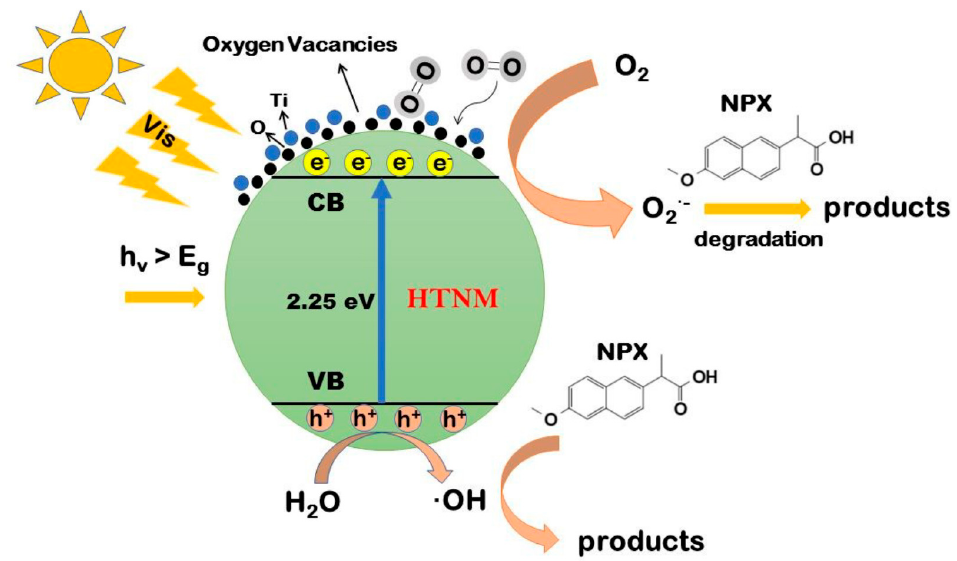
Figure 3. The possible mechanism describing the photocatalytic degradation of NPX by HTNM in the presence of visible light irradiation. Reprinted/adapted with permission from Ref. [89]. Copyright 2019 Royal Society of Chemistry.